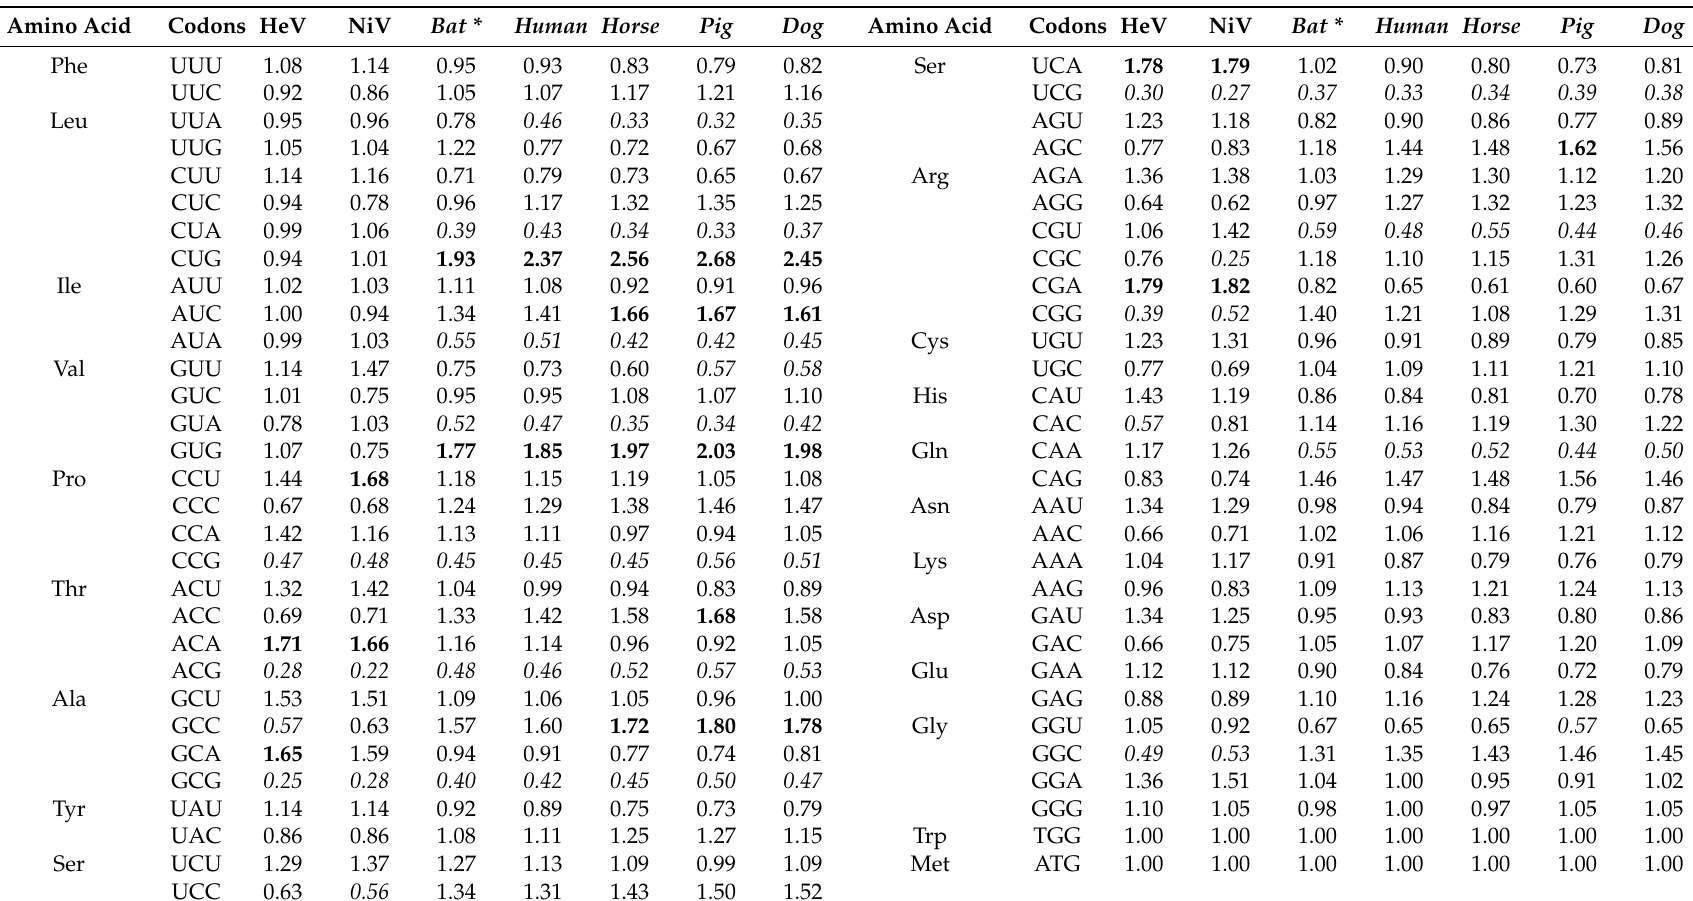
Table 1. The Relative synonymous codon usage (RSCU) patterns of HeV and NiV with their host